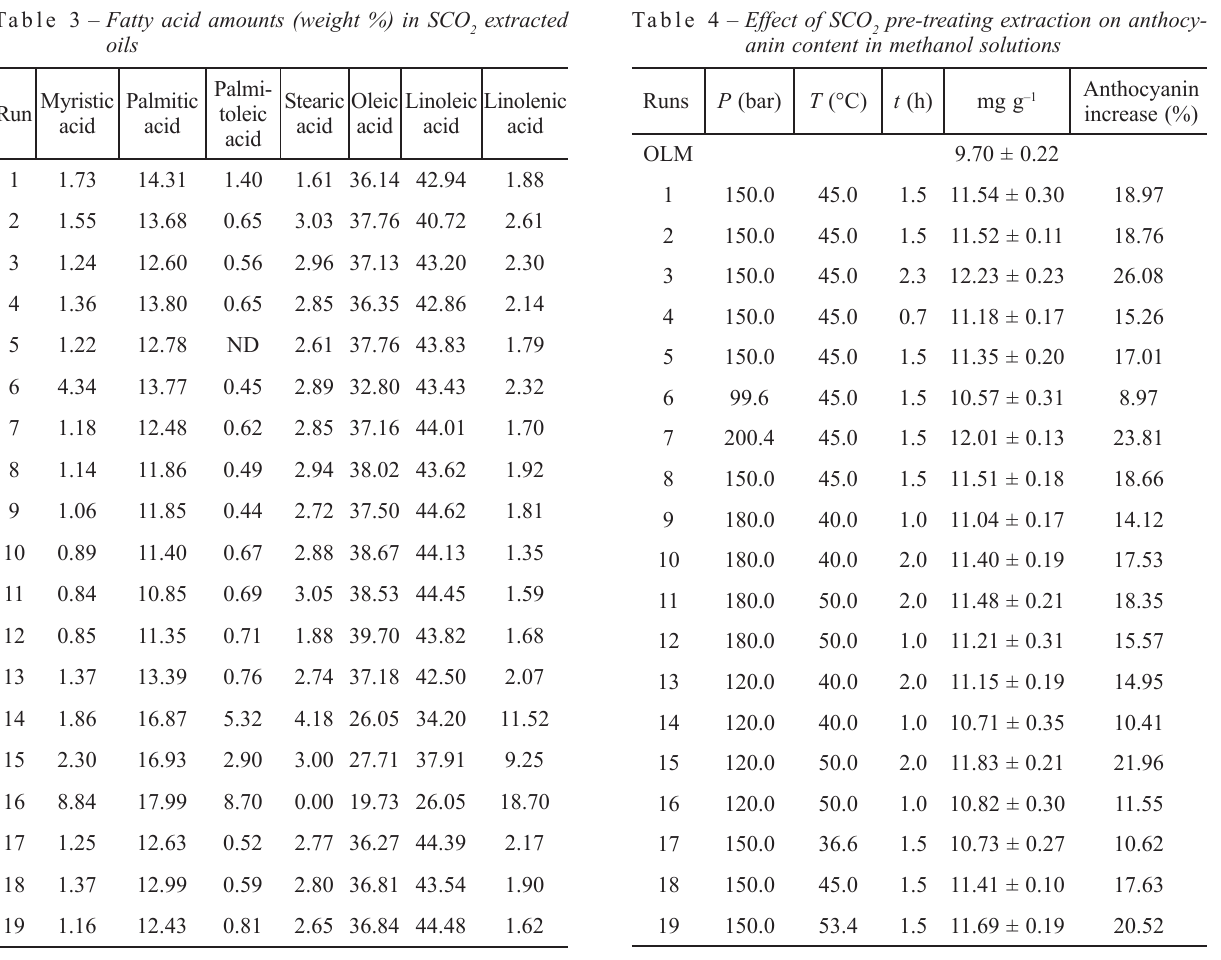
pre-treating extraction on anthocy- 2